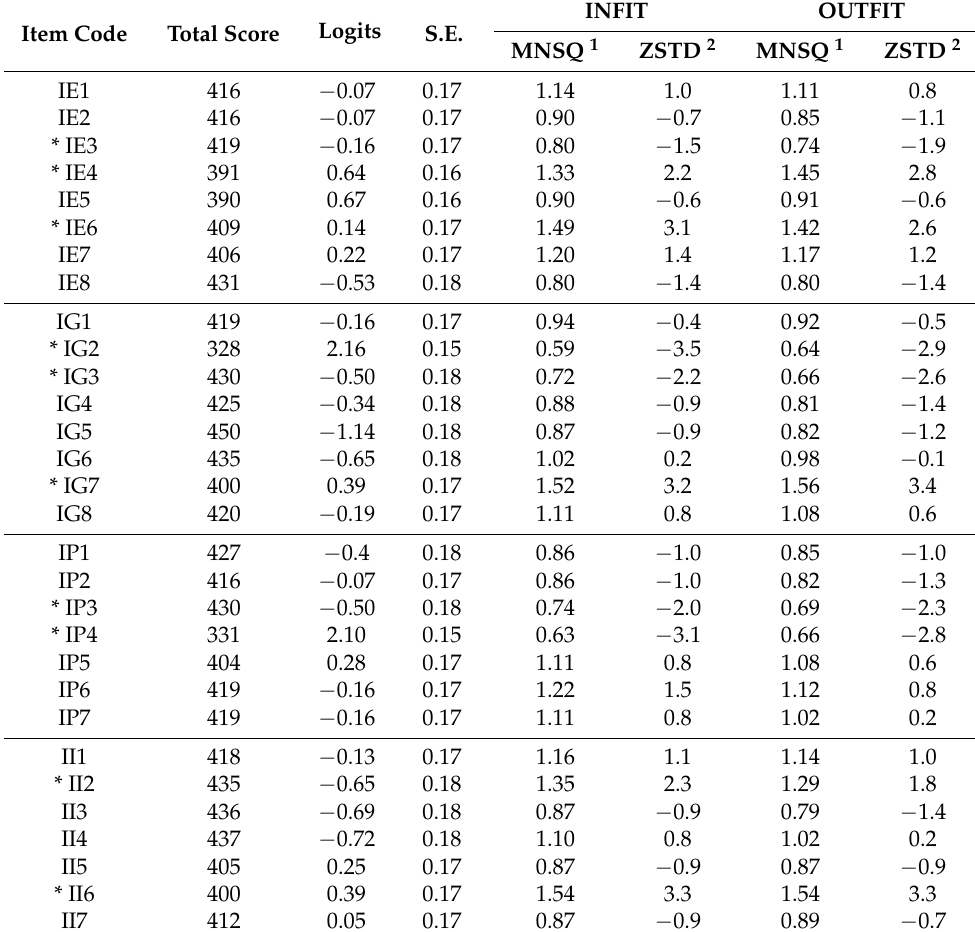
Table 3. Item fit for innovative behaviour